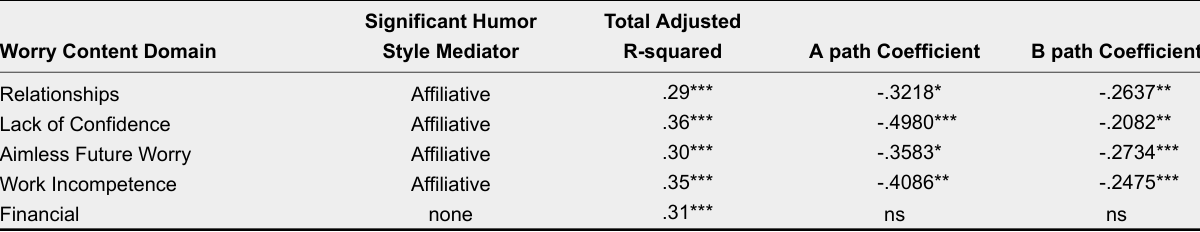
Significant Humor Style Mediators for Each Worry Content